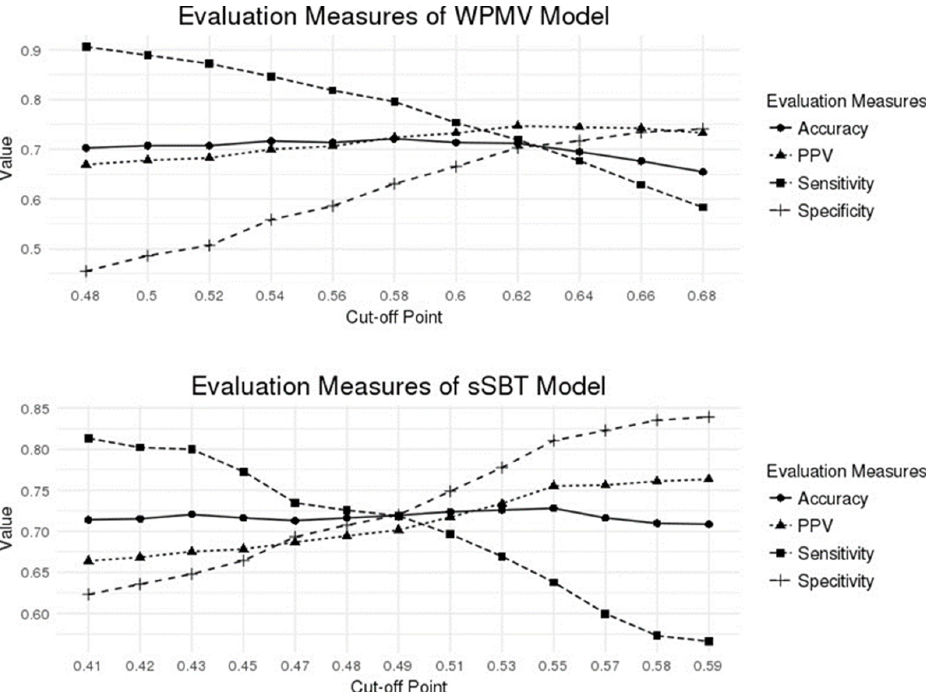
Figure 4. Evaluation measures under different cut-off points of weaning probability of mandatory ventilation model and successful spontaneous breathing trail model.